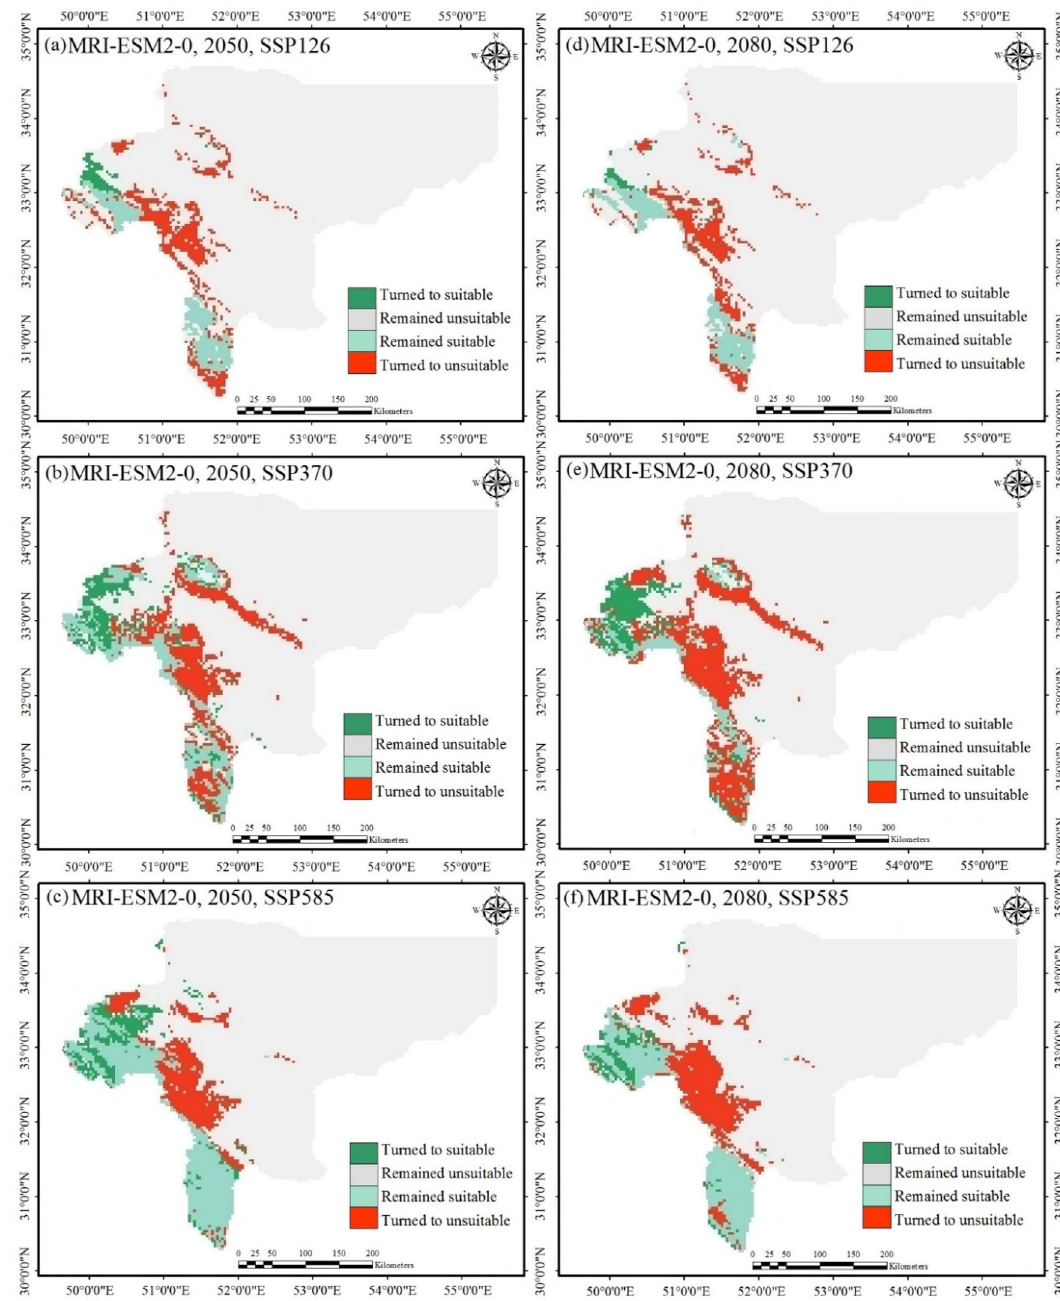
Figure 7. Changes in the suitable habitat distribution for S. inflata under current and the climates of 2050 ( a – c ) and 2080 ( d – f ) under the second GCM. Each part displays a different year and emissions